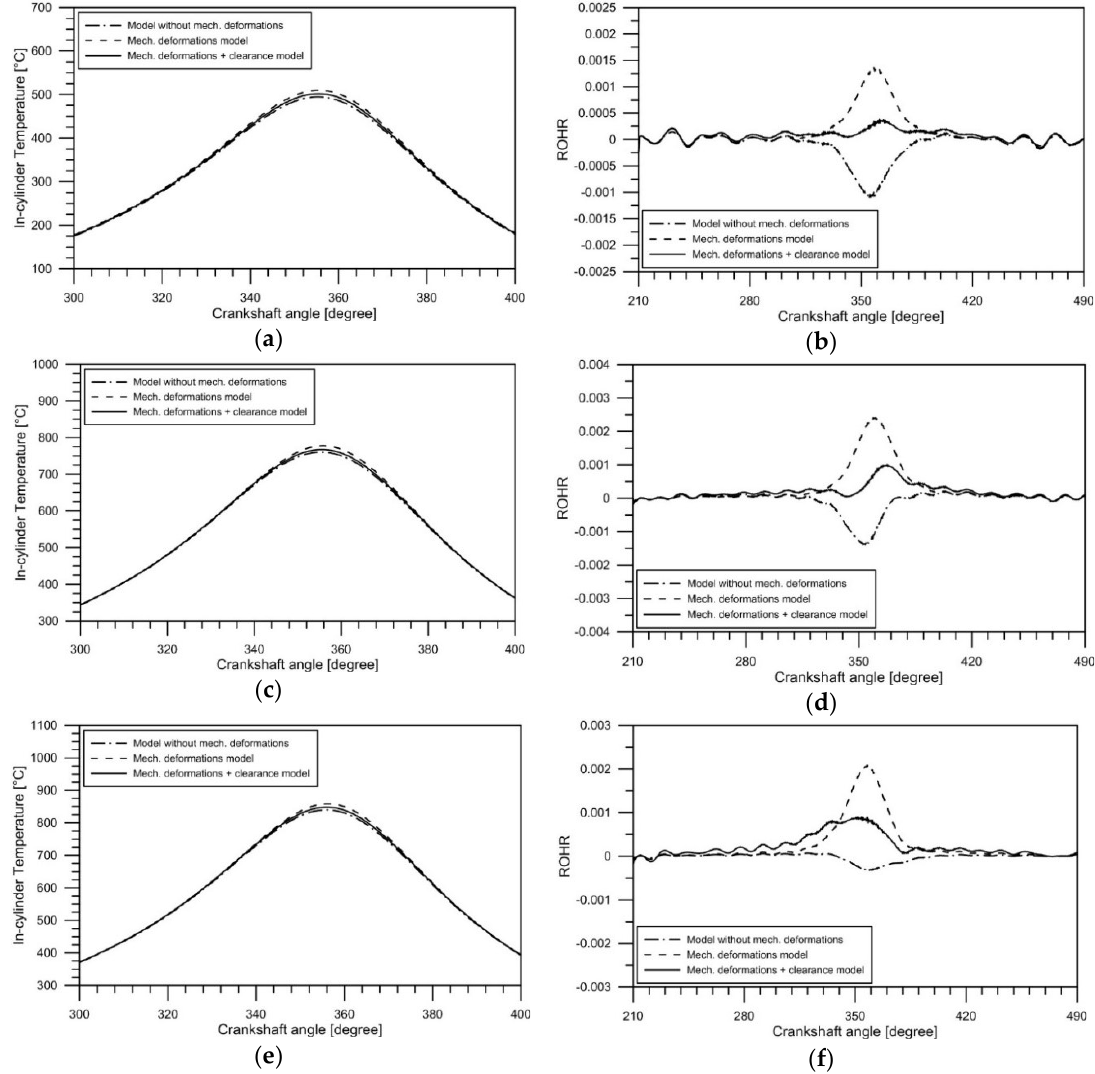
Figure 15. Results obtained for ( a , c , e ) in-cylinder temperature and ( b , d , f ) rate of heat release for 1500 rpm, 2500 rpm, and 3500 rpm, respectively.